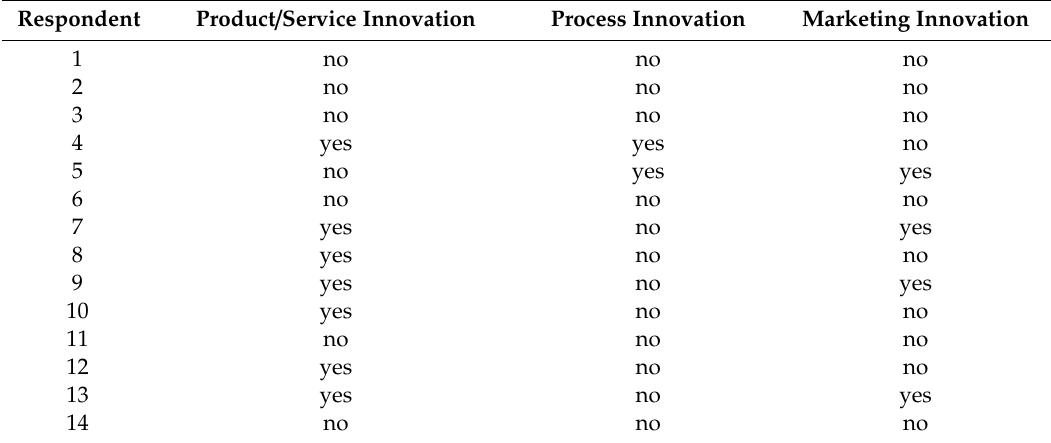
Table 4. Comparison of innovation delivery in the